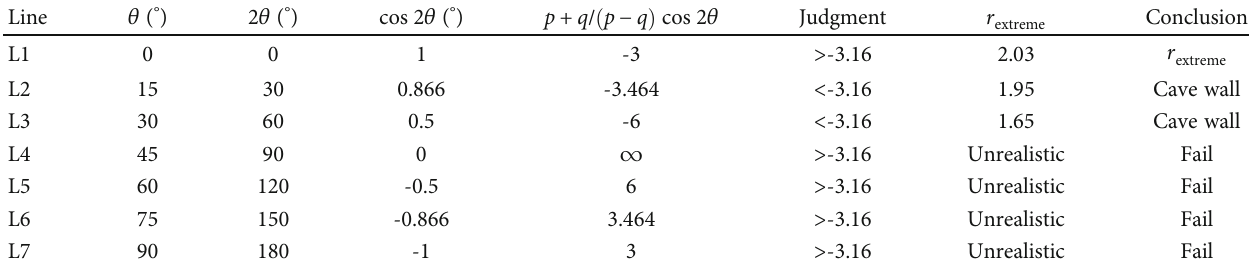
Table 3: The sensitivity of the displacement to the radius.